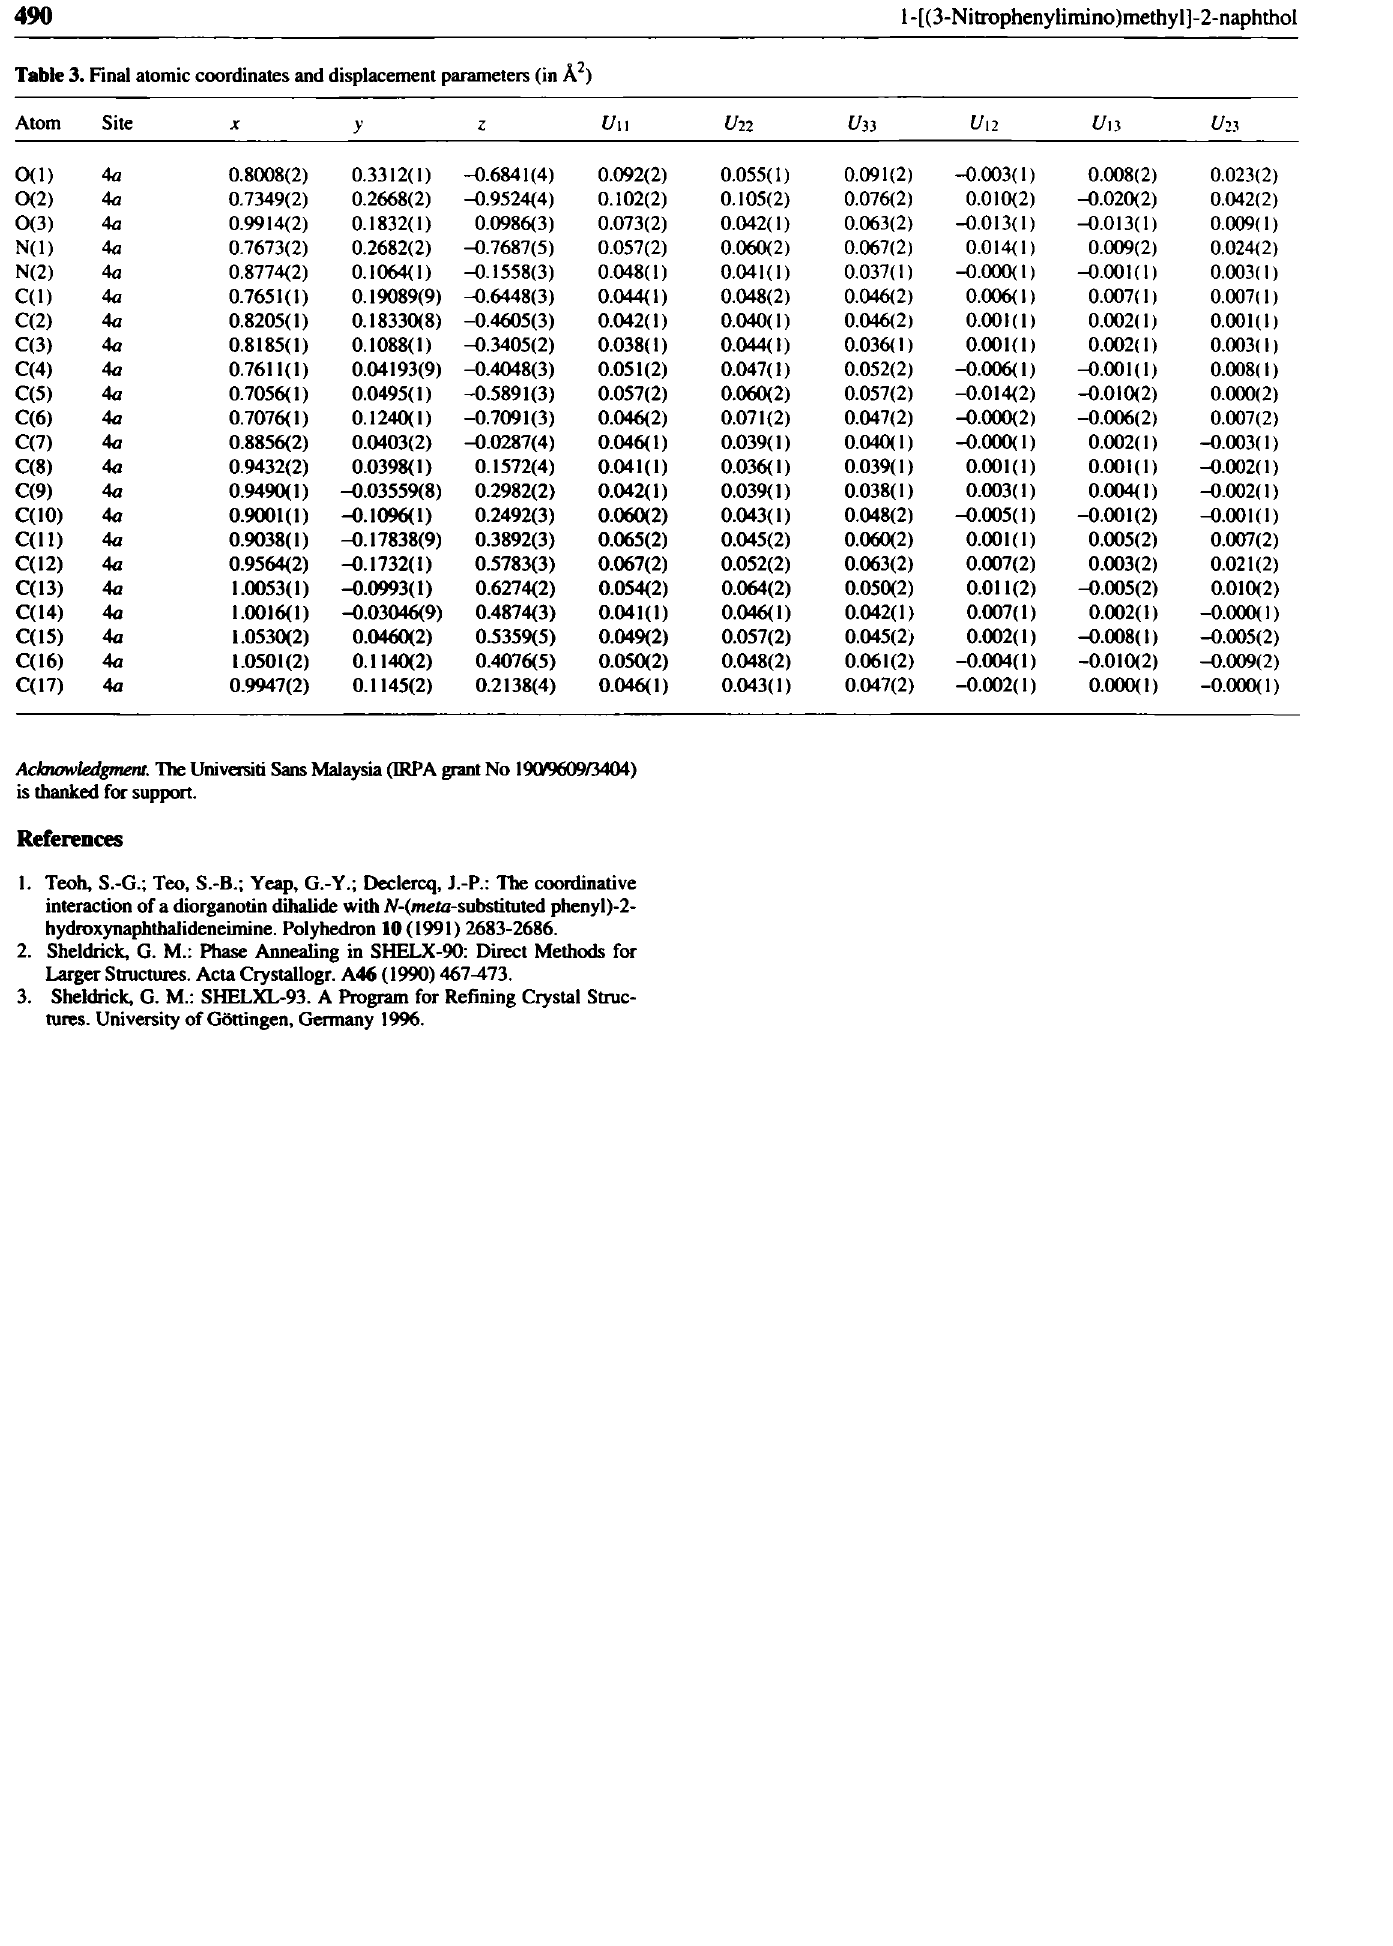
Table 3. Final atomic coordinates and displacement parameters (in